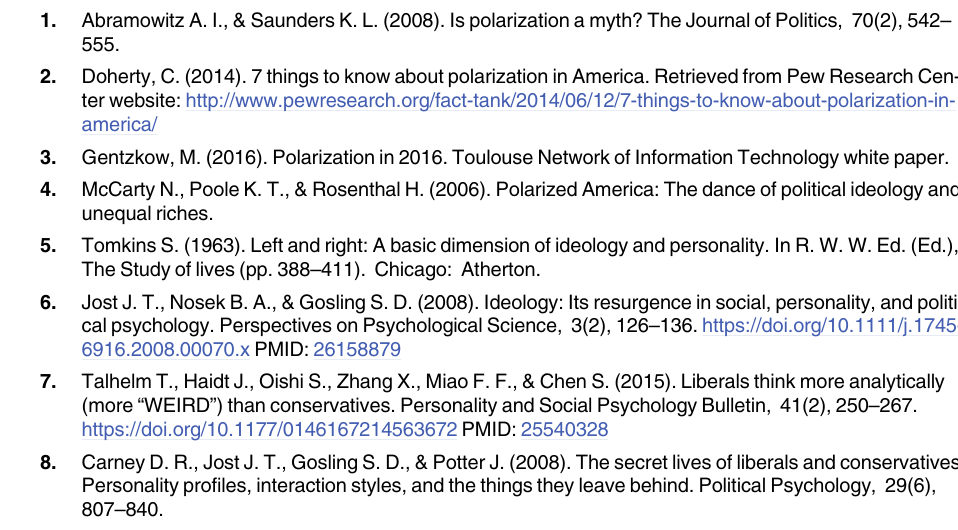
S1 Table. Percentage of respondents across options for eight moral issues for Democrats, Republicans, and Independents in the United States. S2 Table. Percentage of respondents across options for five freedom of speech statements for Democrats, Republicans, and Independents in the United